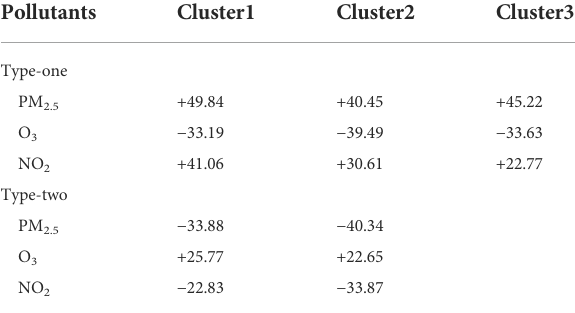
TABLE 1 Absolute anomalies and relative anomalies of PM 2.5 , O 3 and NO 2 concentrations in each backward trajectory cluster of the two seesaw events in Shanghai. Units: μ g/m 3 . The anomalies are with respect to their average value of every hour in every month.